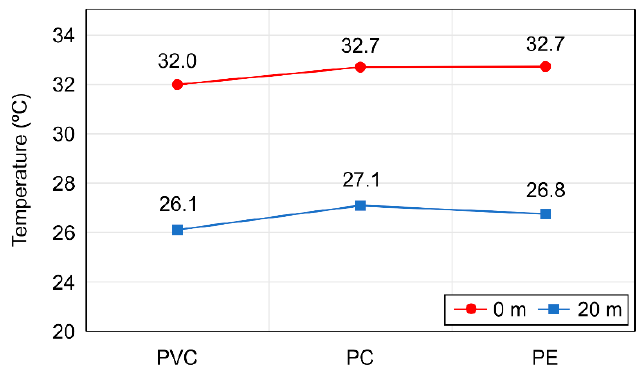
Figure 10. The temperature differences between x = 0 m and x = 20 m for various plate quantities.